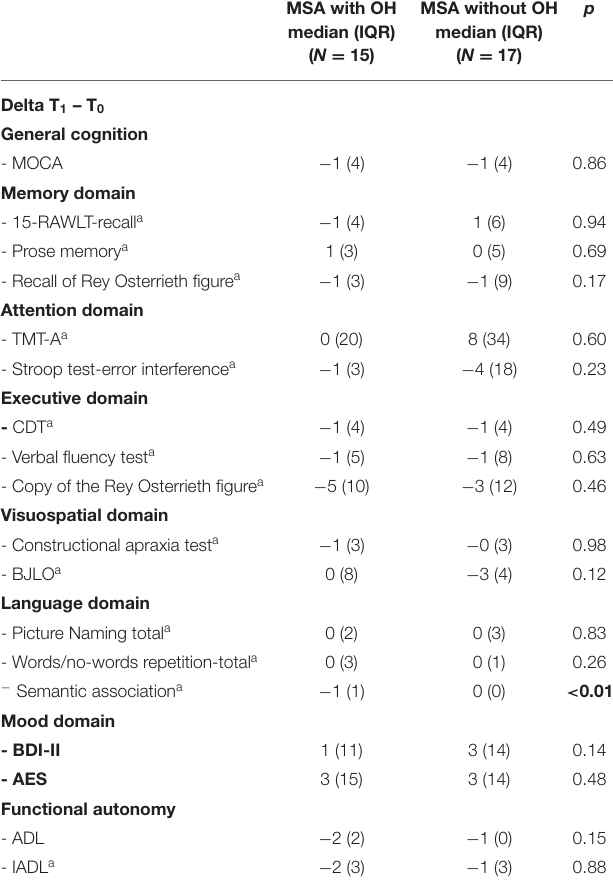
TABLE 2 | Changes in neuropsychological tests in MSA patients with and without OH at T 1